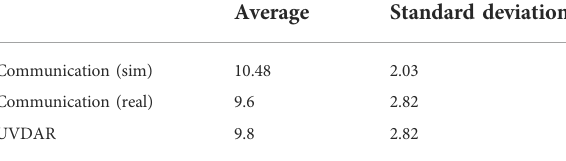
TABLE 1Reportedaverage distance between drones inthe swarm and its standard deviation during simulated and real experiments with